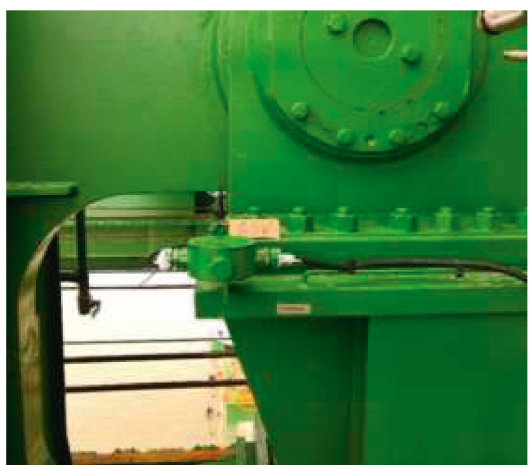
Figure 3: Installation position of quay crane vibration sensor on quayside hinge.